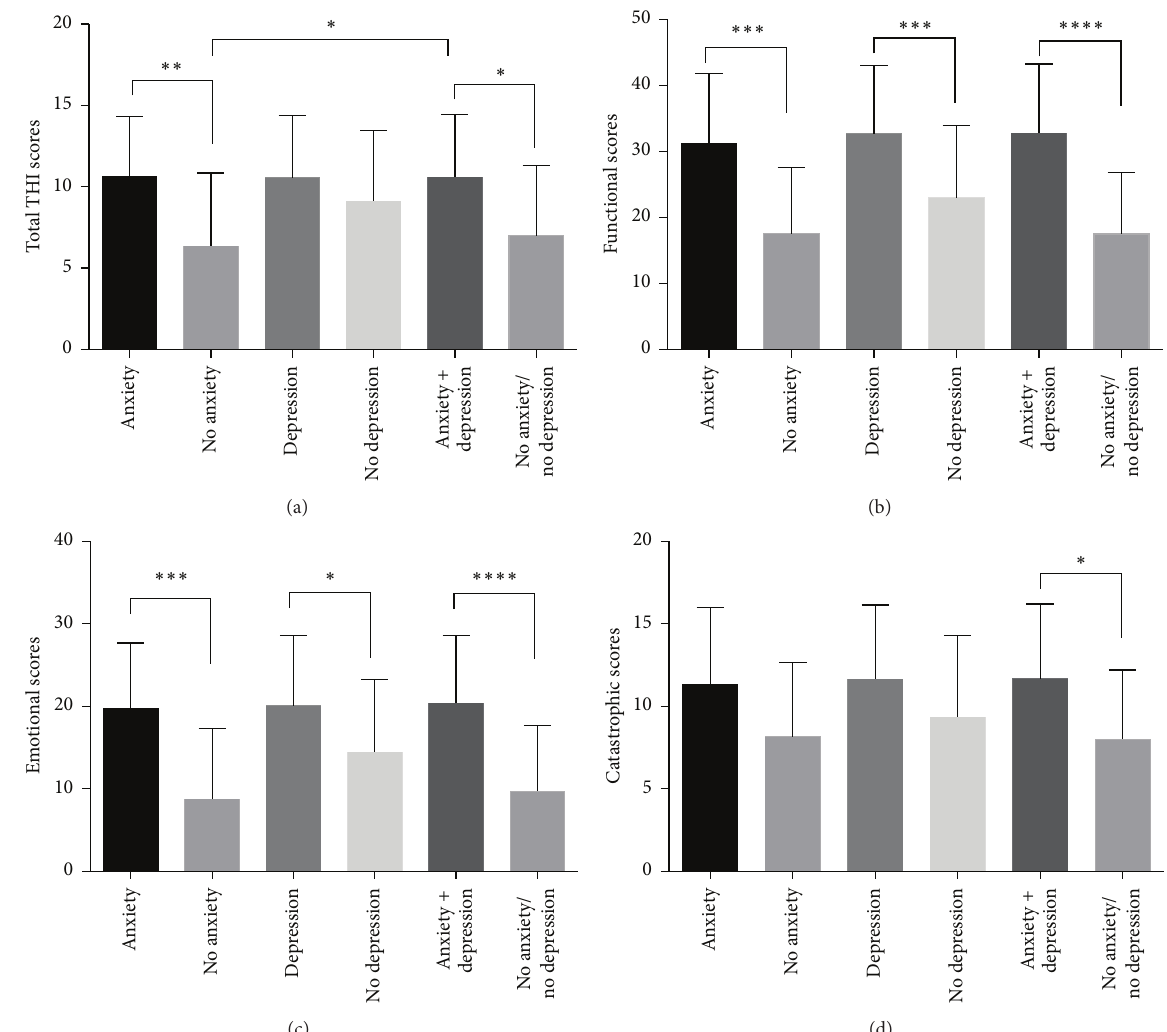
Figure 2: Tinnitus severity presented with total THI (a) and functional (b), emotional, (c) and catastrophic subscales (d) among tinnitus patients with and without anxiety and depression. ∗ 𝑝 < 0.05; ∗∗ 𝑝 < 0.01; ∗∗∗ 𝑝 < 0.001; and ∗∗∗∗ 𝑝 <